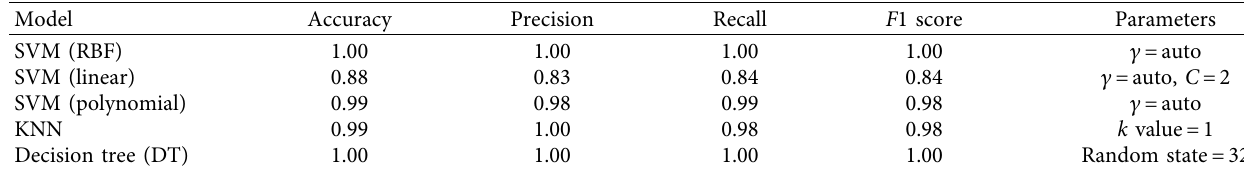
Table 15: Conscientiousness classifcation